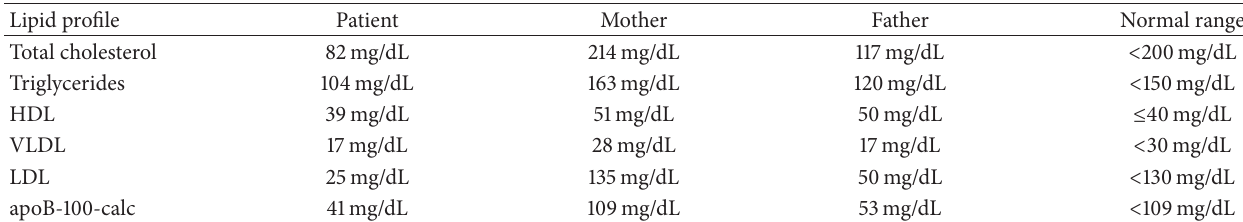
Table 1: Lipid profile values of the patient and his